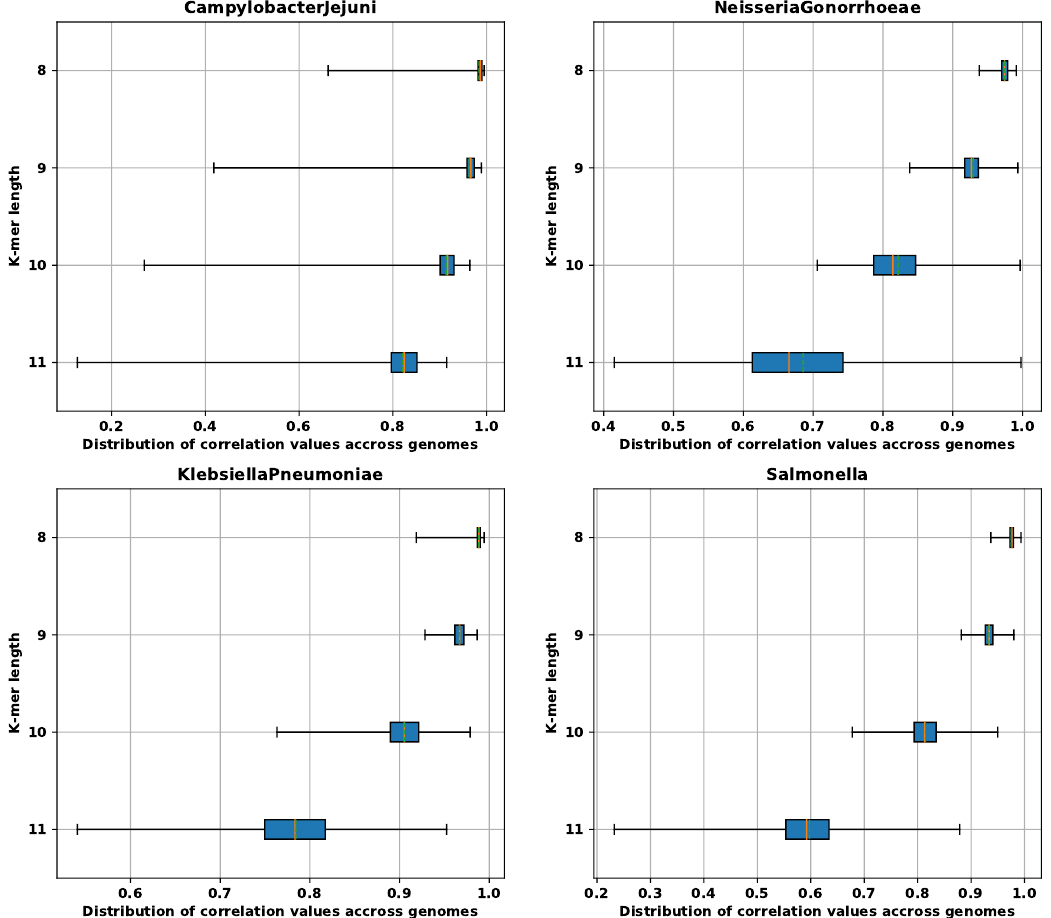
Figure A12. Distribution of correlation coefficient between the frequencies of canonical and non-canonical features, when both frequencies are counted separately across the genomes for different microbes and different k -mer lengths. In each box plot, the whiskers represents the maximum and minimum. The boxes represent the first and the third quartiles. The orange line represents the median and the green line represents the